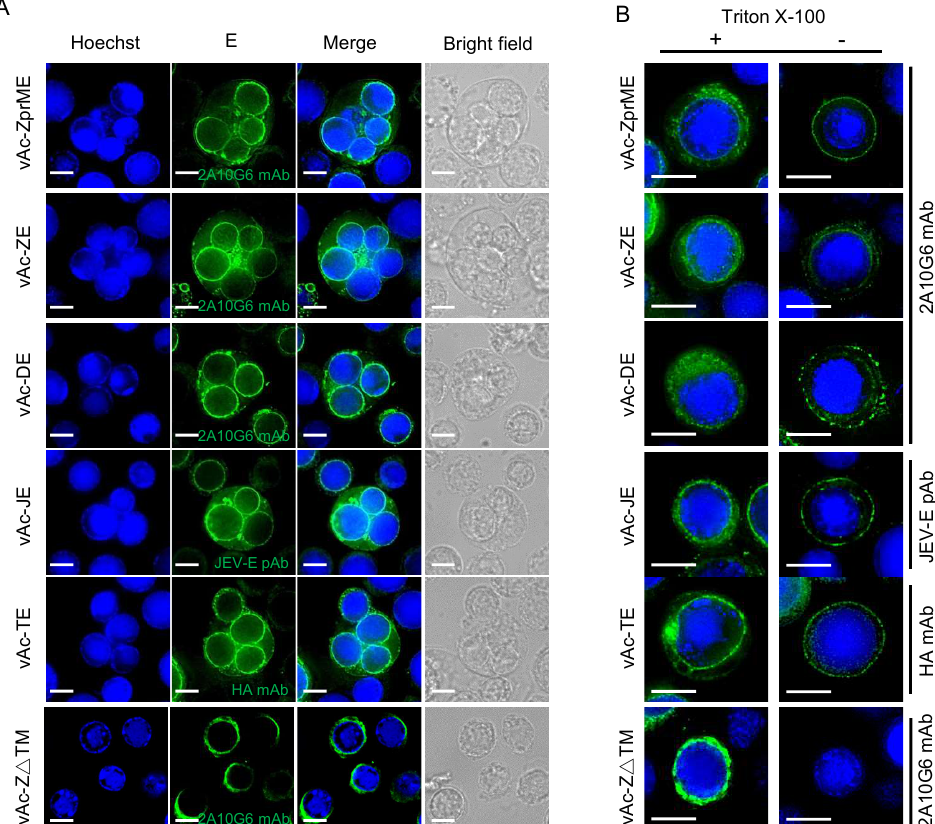
Figure 3. Subcellular localization of baculovirus-expressed flavivirus E proteins in Sf9 cells. ( A ) Sf9 cells were infected with vAc-ZprME, vAc-ZE, vAc-DE, vAc-JE, vAc-TE, and vAc-ZE ∆ TM at an MOI of 5. E proteins (green) were detected with indicated antibodies. Nuclei were stained with Hoechst as shown in blue. Bars, 5 µ m. ( B ) Cell-surface expression of E protein analyzed by immunofluorescence. Cells were permeabilized with Triton X-100 (left panels) or not treated (right panels), and immunostained with indicated antibodies. Bars, 5 µ